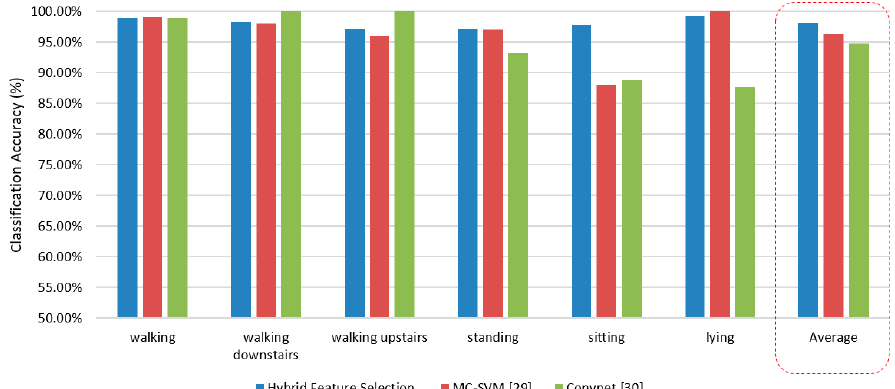
Figure 9. Individual activity accuracies with and without feature selection.